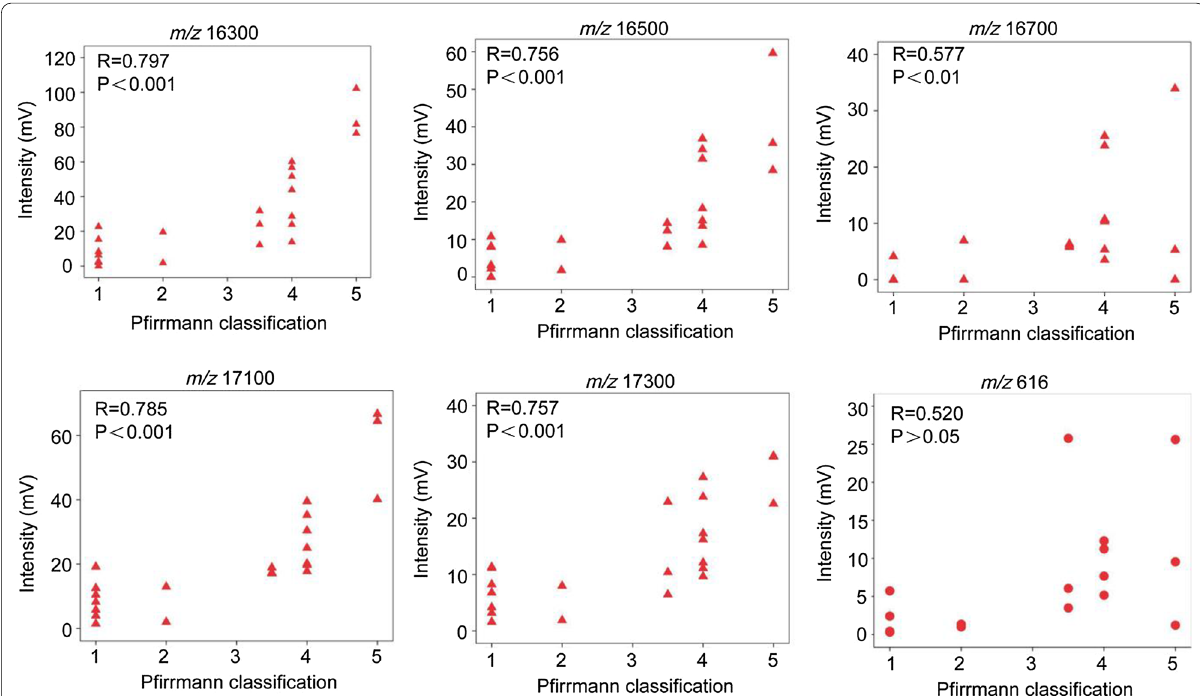
Fig. 4 Pearson correlation analysis of Pfirrmann classification and intensity of MALDI-TOF MS